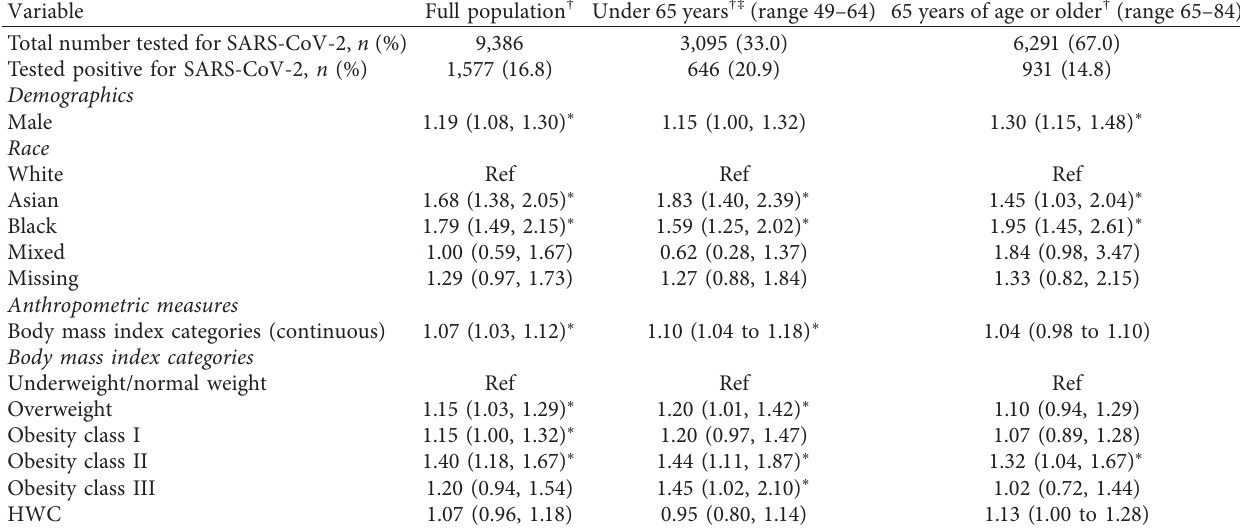
Table 3: Association between measures of adiposity and testing positive for SARS-CoV-2 overall and stratified by older age.